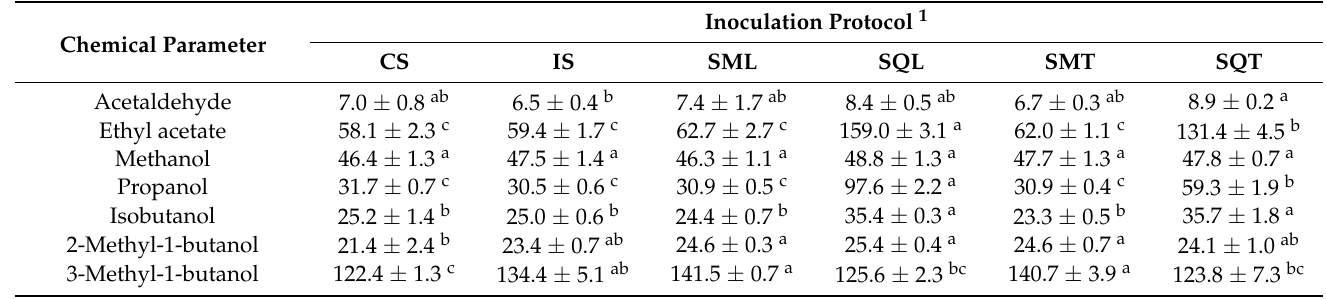
Table 2. Major volatiles (mg/L) of ferments produced in laboratory-scale fermentations of sterile must (mean ± SD, n = 3). Different letters indicate significantly different values ( p <